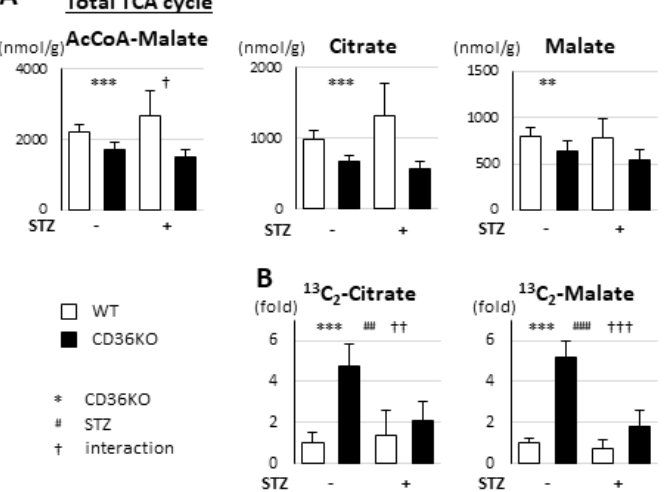
Figure 4. Pool size in TCA cycle was significantly reduced in CD36KO-STZ hearts. Hearts were isolated after a 6 h fast for metabolome analysis. ( A ) Metabolic profiling in TCA cycle ( n = 5–7). TCA cycle, tricarboxylic acid cycle. ( B ) Tracer study with 13 C 6 -glucose. After a 6 h fast, hearts were isolated 10 min after intraperitoneal injection of 13 C 6 -glucose ( n = 5–7). ** p < 0.01, *** p < 0.001; main effect for genotype. ## p < 0.01, ### p < 0.001; main effect for STZ treatment. † p < 0.05, †† p < 0.01, ††† p < 0.001; interaction between genotype and STZ treatment.